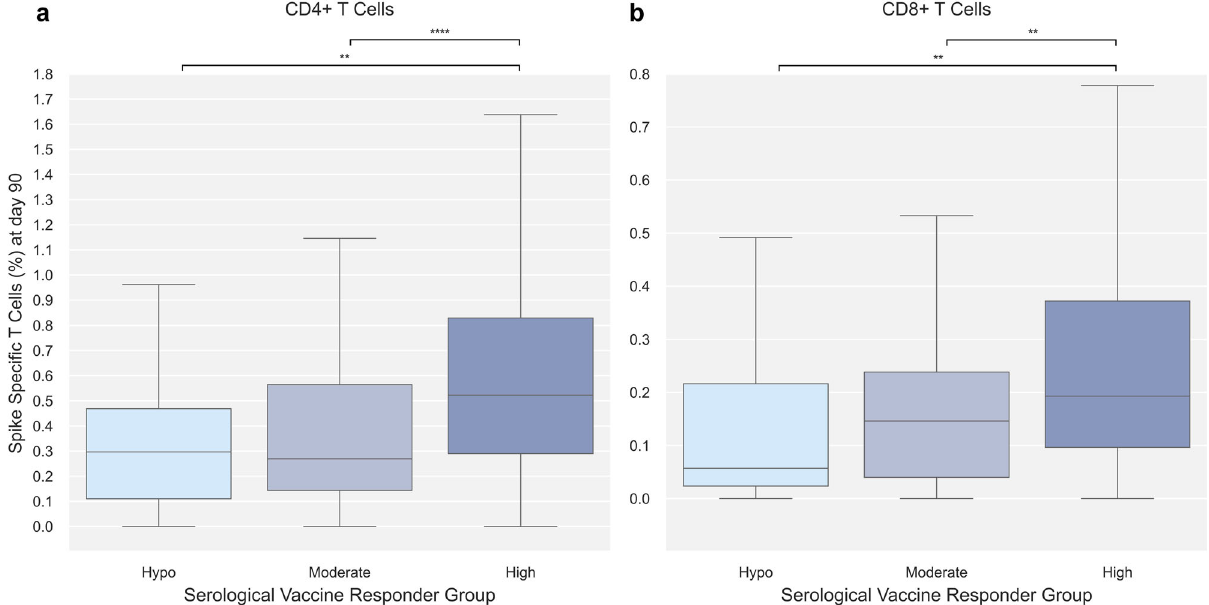
Fig. 4 SARS-CoV-2 Spike-speci fi c T cells at day 90 by serological vaccine responder group. Day 90 SARS-CoV-2 Spike-speci fi c T cells strati fi ed by serological vaccine responder group (Hypo [light blue], Moderate [blue], High [dark blue]). Serological vaccine responder group was de fi ned based on the change in Spike IgG at day 90 relative to their pre-vaccine (baseline) levels: vaccine hypo-, moderate- and high responders were individuals with a log 10 fold change of <2, 2-3, or >3 in Spike IgG, respectively. a SARS-CoV-2 Spike-speci fi c CD4 + T cells; n = 46 (Hypo), n = 105 (Moderate), n = 318 (High). b SARS-CoV-2 Spike-speci fi c CD8 + T cells; n = 36 (Hypo), n = 101 (Moderate), n = 309 (High). Data was compared using unpaired, non-parametric Mann – Whitney U -test. Error bars show the distribution within 1.5 times IQR. p -value annotation legend: *1.00·10 − 02 < p ≤ 5.00·10 − 02 , **: 1.00·10 − 03 < p ≤ 1.00·10 − 02 , ***1.00·10 − 04 < p ≤ 1.00·10 − 03 , **** p ≤ 1.00·10 − 04